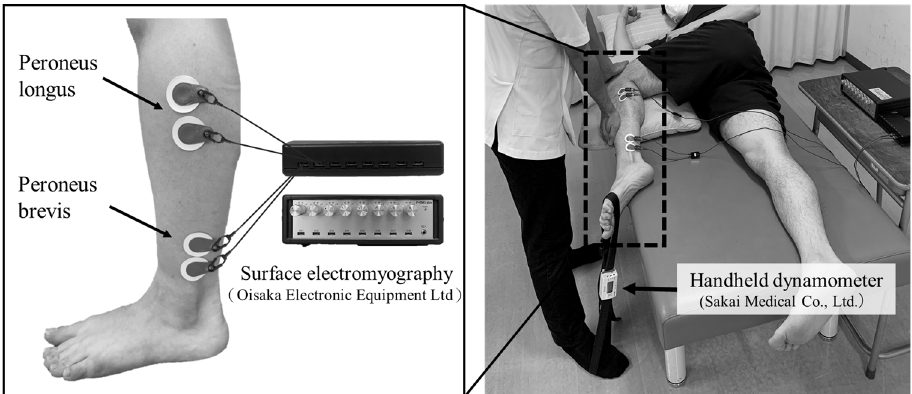
Figure 3. Measurements of the PL and PB muscle activity during ankle eversion by surface electro- myography, and ankle evertor strength using a handheld dynamometer. The subject was placed in the lateral position on the bed, with the upper leg at 90° hip and knee flexion and the lower leg at 0° to the hip and knee joints. The belt of the handheld dynamometer was placed on the fifth meta- tarsal head of the foot of the upper leg, and the subject performed an isometric ankle eversion with maximum effort for 5 s in the maximum plantar flexion position.